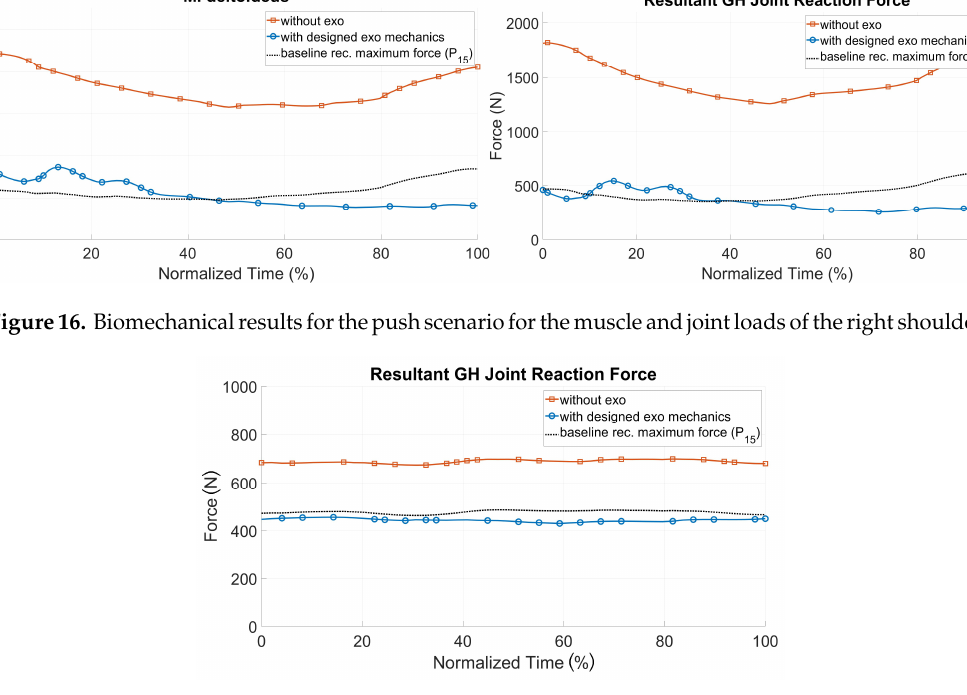
Table 3. Overview of the influence of exoskeleton use on key biomechanical parameters for the pushing task in comparison to those with an exoskeleton, without an exoskeleton and without an exoskeleton and recommended pushing force quantity.